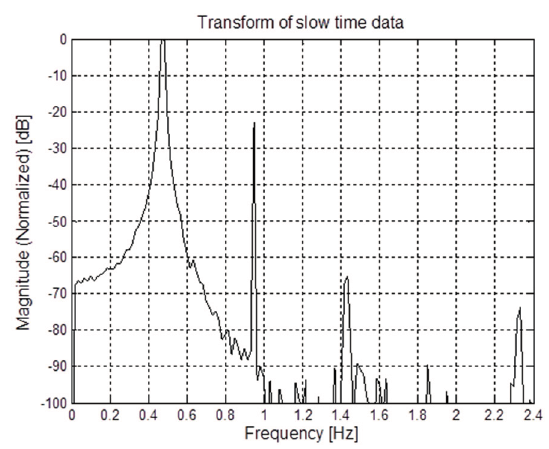
Figure 14. Iterated FFT around the τ 0 estimate.